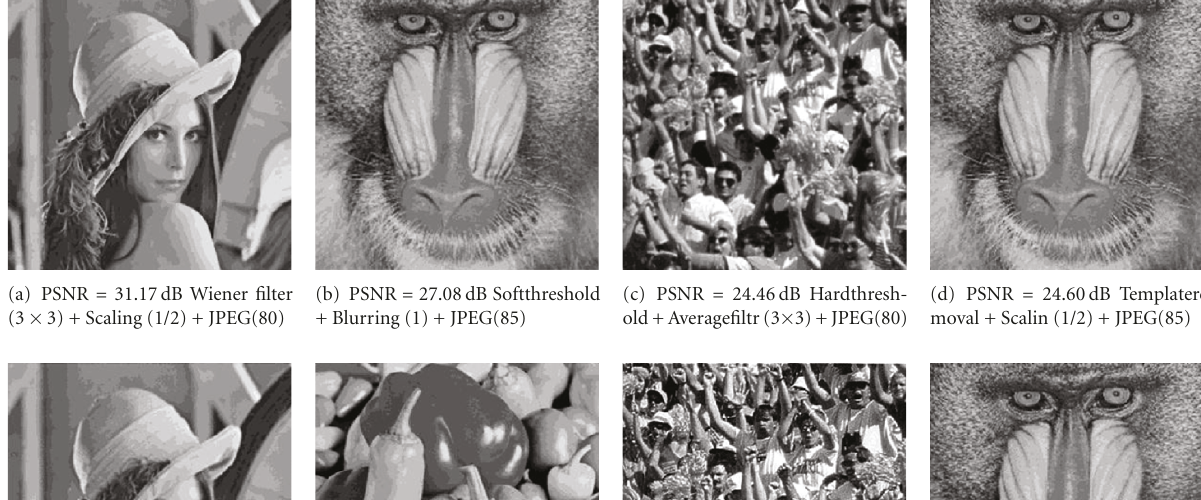
PSNR of watermarked images and extracted